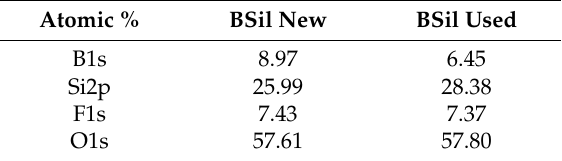
Figure 10. X-ray photoelectron spectroscopy (XPS) analysis of BSil ( a ) before and ( b ) after use in the reaction of biodiesel production. Table 1. Comparison between freshly prepared and used BSil characterized by X-ray photoelectron spectroscopy (XPS).